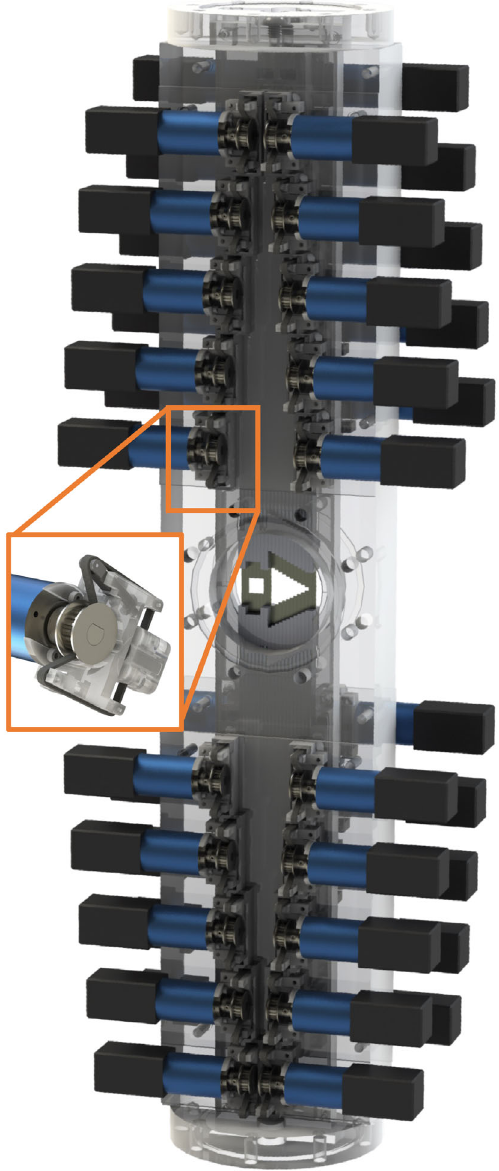
FIG. 3. A render of the multileaf collimator with the vacuum chamber and some support structures made translucent for clarity, shown here creating a mask for a ramped drive beam and witness beam. Inset shows a drivetrain module (compare to Fig.